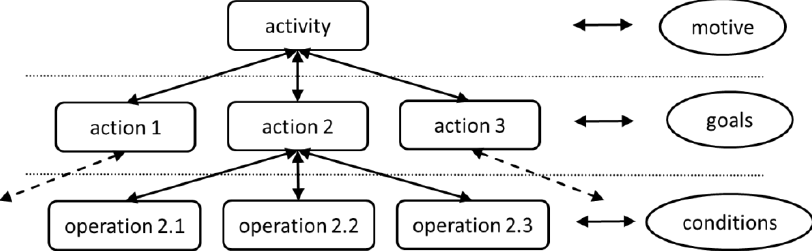
Figure 2. Hierarchical structure of an activity (reproduced from [26], Figure 3.4, © Massachusetts Institute of Technology, by permission of The MIT Press ).